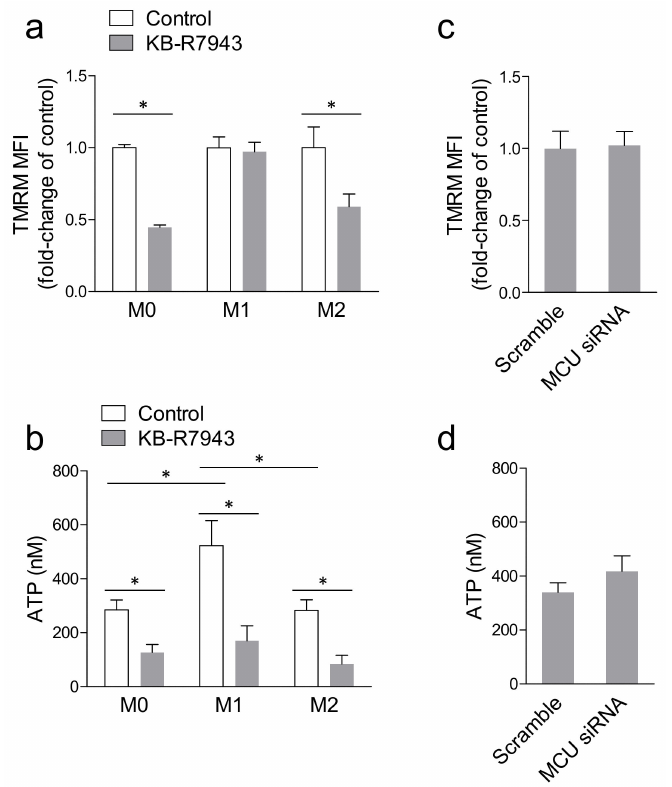
Figure 5. E ff ects of MCU blocking on mitochondrial potential and ATP levels. ( a ) Mitochondrial membrane potential was evaluated by flow cytometry in resting (M0), M1- and M2-polarized macrophages loaded with TMRM, with and without the MCU inhibitor KB-R7943: * p < 0.05 for the comparison between control (set at 1.0) and KB-R7943. ( b ) Cellular ATP levels were measured by a luminescence assay in M0, M1, and M2 macrophages with and without the MCU inhibitor KB-R7943 (* p < 0.05after2-wayANOVA).( c )AverageTMRMfluorescenceintensityinM2macrophagestransfected withscramblesiRNAorwithsiRNAagainstMCU.( d )CellularATPlevelsinM2macrophagestransfected with scramble siRNA (set al. 1.0) or with siRNA against MCU